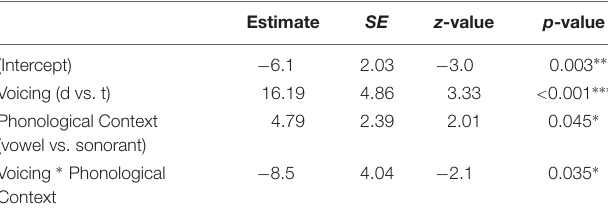
TABLE 4 | Regression model of production accuracy in Experiment 1.